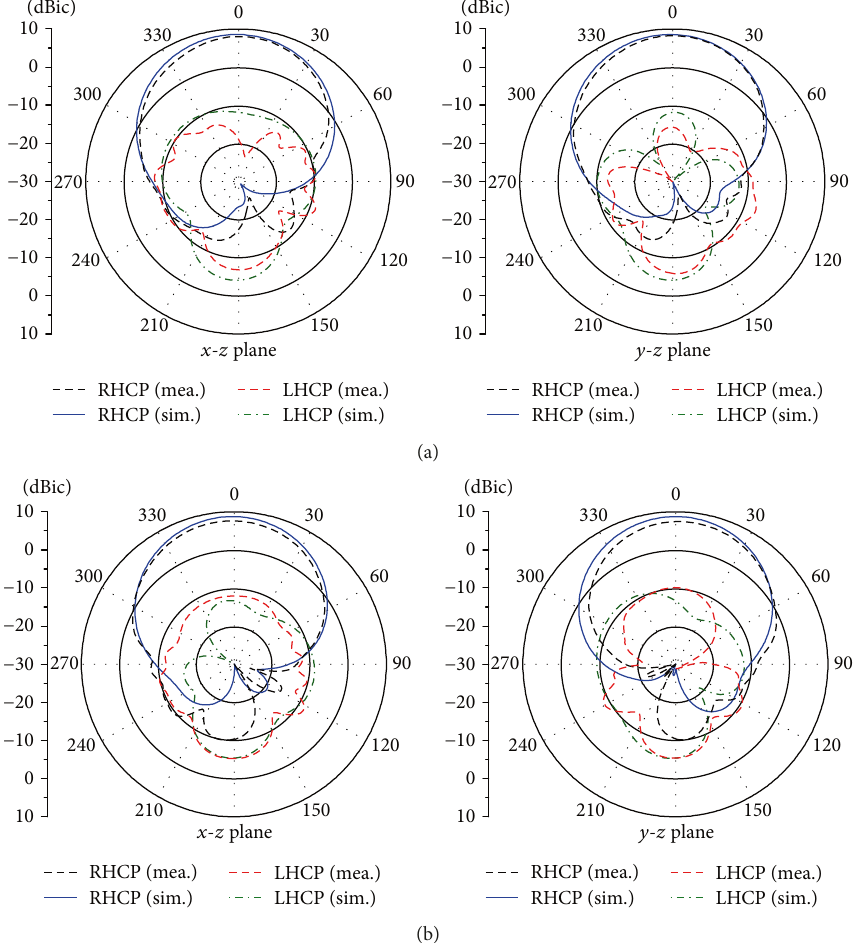
Figure 14: Simulations and measurements of the crossed-dipole antenna loaded with parasitic patches: (a) 1.52GHz and (b) 1.64GHz radiation